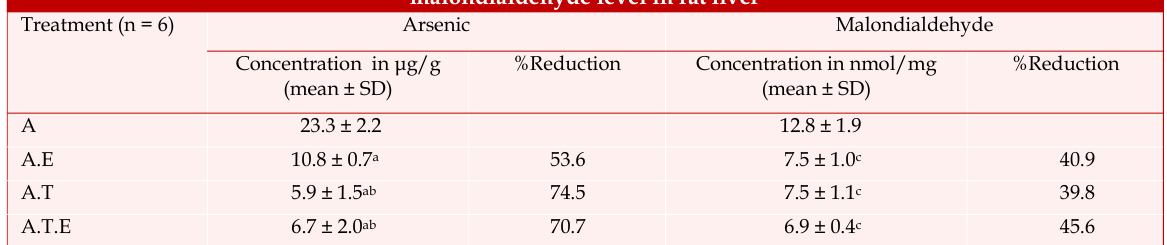
Effect of α - tocopherol and water hyacinth extract administered alone or in combination on arsenic